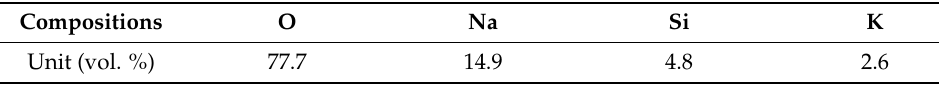
Table 3. Chemical composition of admixture. Compositions O Na Unit (vol. %)